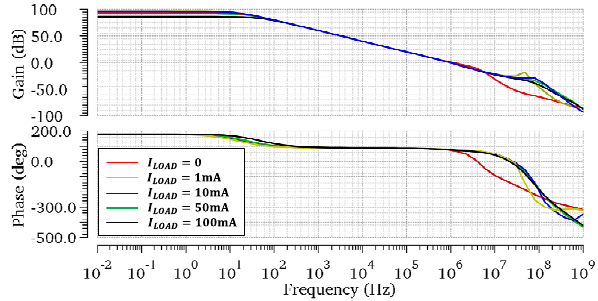
Figure 6. Simulated open − loop gain at different load currents with 𝐶 (cid:3013) = 100 pF .